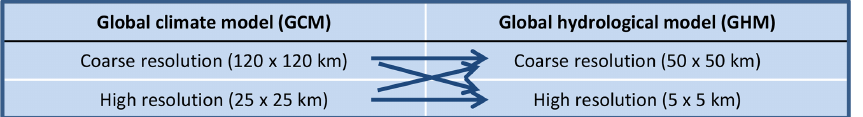
Figure 1. Two spatial resolution simulations of the GCM are used to force the GHM with two different spatial resolutions. Note that this set-up was tested for two large river basins, the Rhine and Mississippi basins.